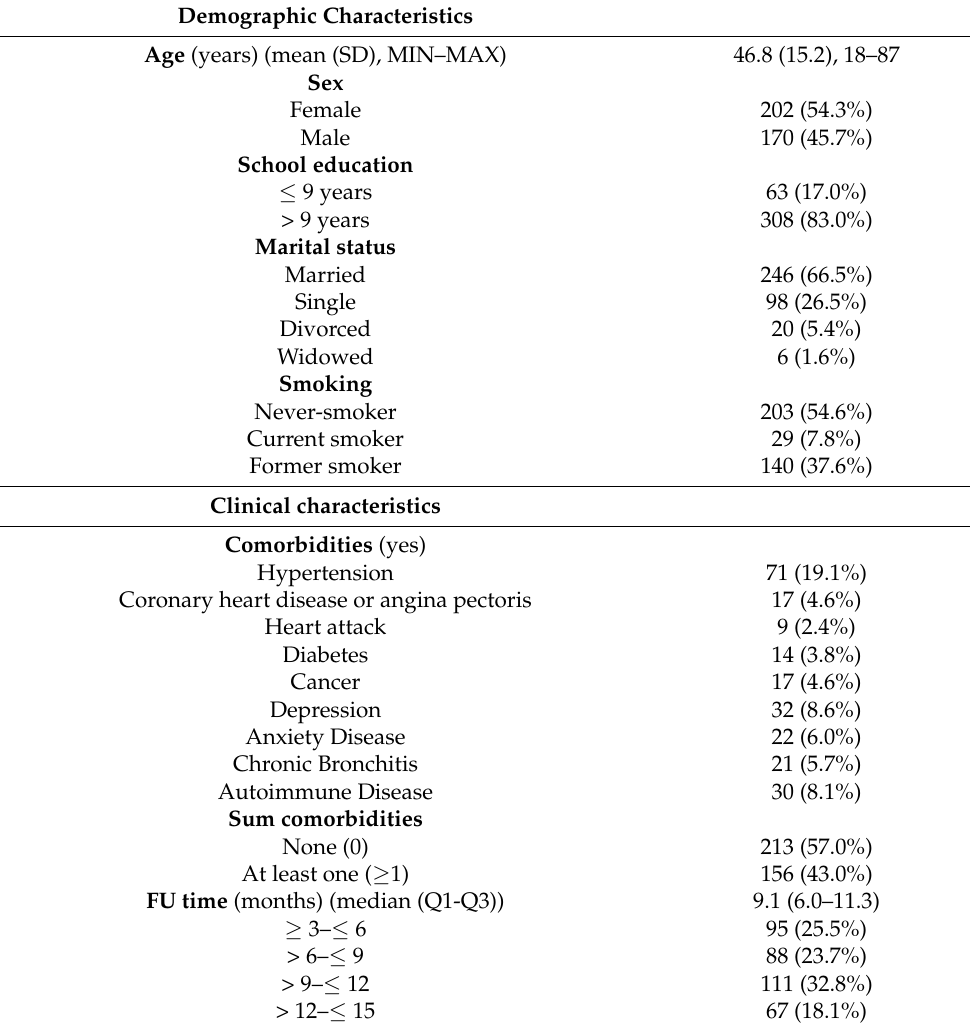
Table 1. Demographic and clinical characteristics of the study sample ( n =